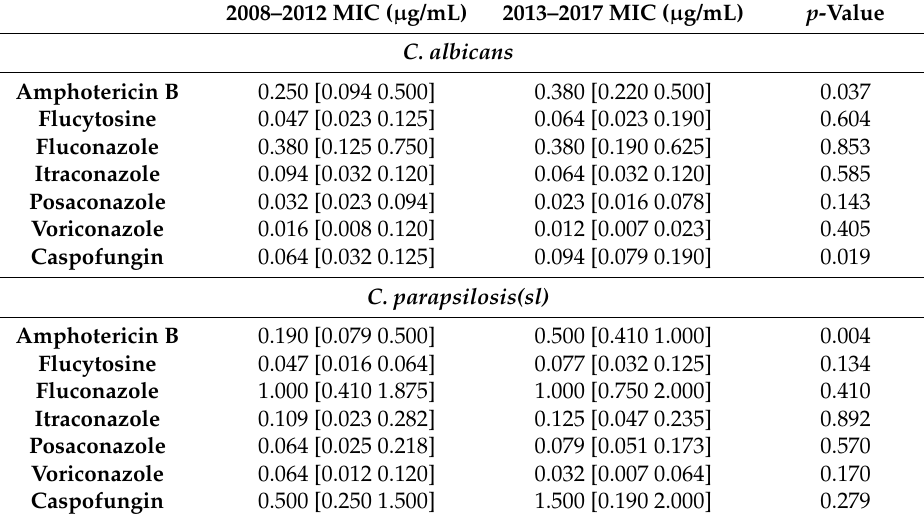
Table 5. Differences in antifungal MICs for C. albicans and C. parapsilosis ( sl ) between two 5-year periods (2008–2012 and